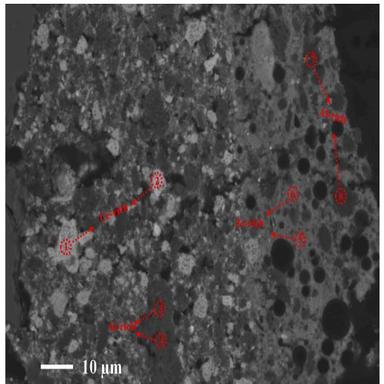
Backscattered electron image of section C6 and areas selected for the spot analyses.